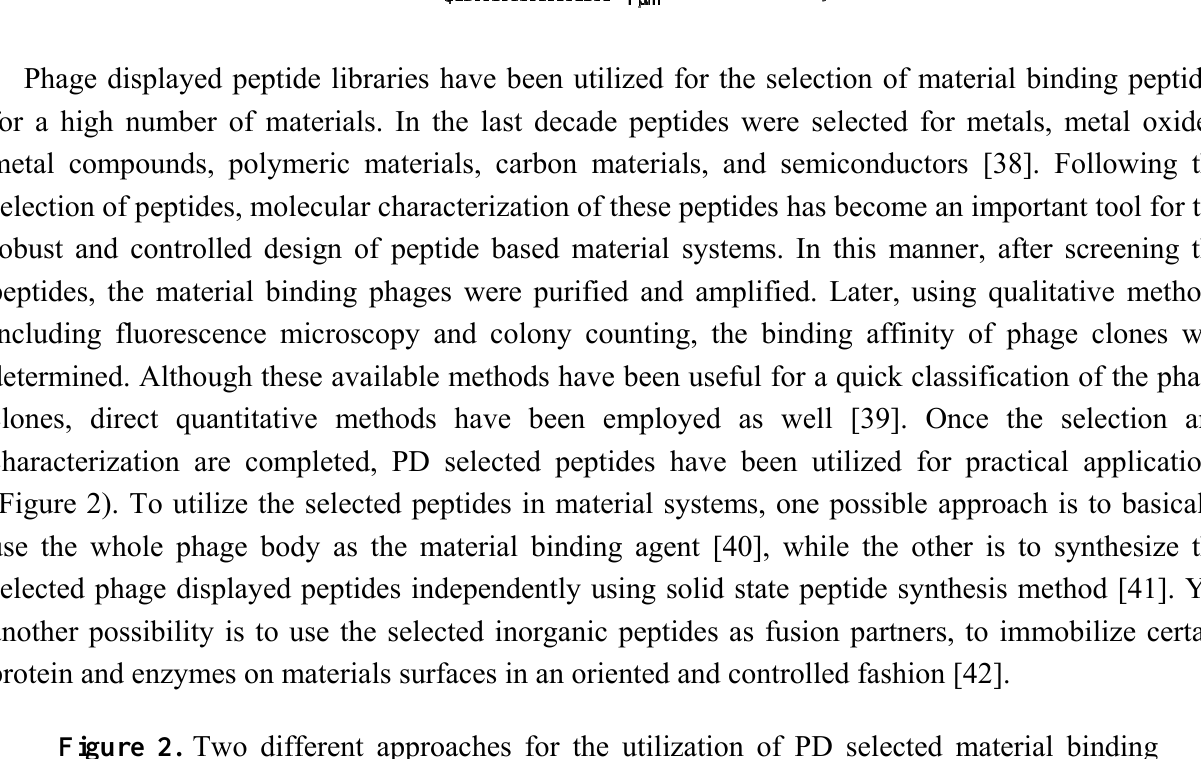
Figure 2. Two different approaches for the utilization of PD selected material binding peptides: (A) PD selected material binding peptides expressed on pVIII major coat protein used to assemble nanoparticles, (B) individually synthesized material binding peptides (in this case with dual functionality) used for the assembly and ordering of nanoparticles on a different material